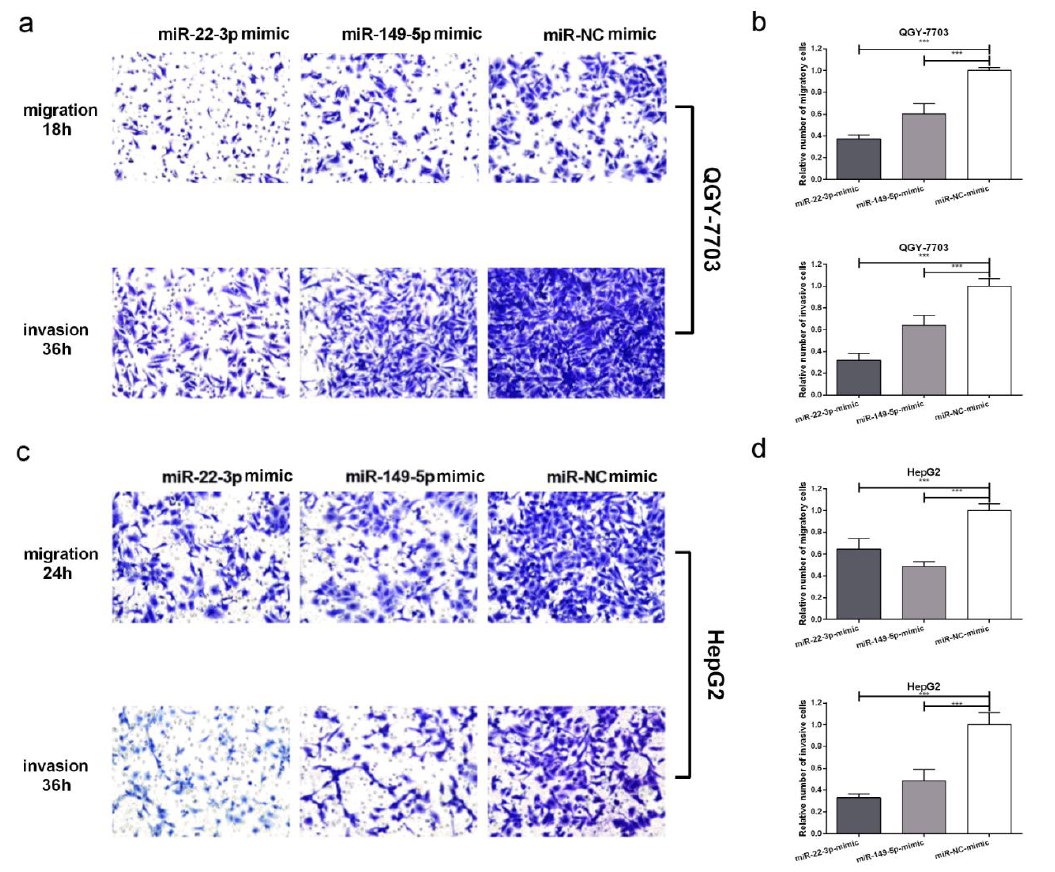
Figure 4. Representative images ( a , c ) and bar graphs ( b , d ) depicting the invasion and migration ability of QGY-7703 and HepG2 after miR-22-3p mimic (100 nM), miR-149-5p mimic (100 nM), or miR-NC mimic (100 nM) transfection. Data are presented as mean ± S.D. ( n = 6) and analyzed by two-tailed unpaired t -test ( × 200 magnification, *** p < 0.001).